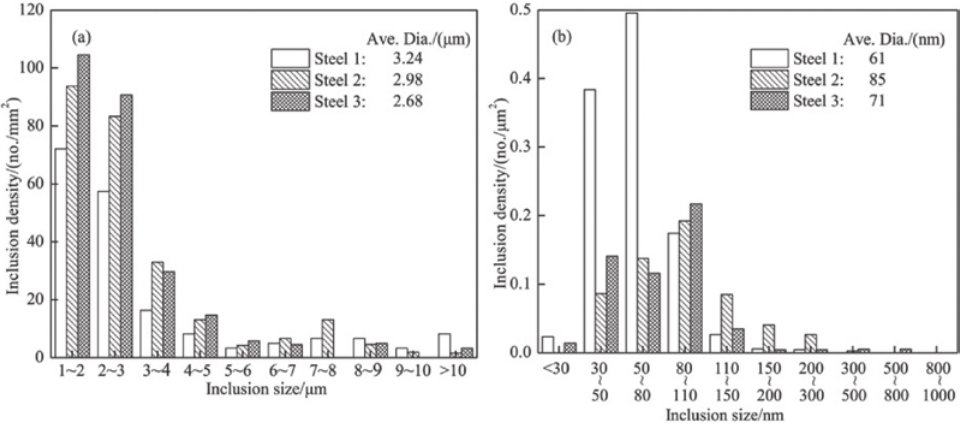
Fig. 3: Inclusion size distribution in tested steels: (a) inclusion distribution for size more than 1 μm; (b) inclusion distribution for size less than 1